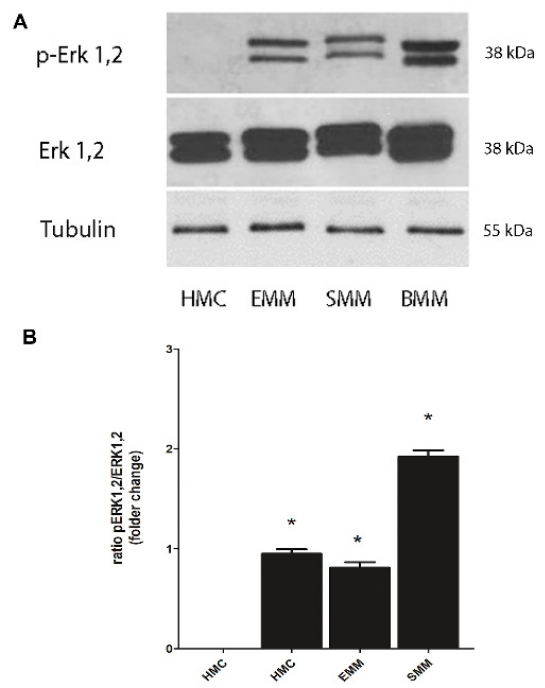
Figure 5. Erk phosphorylation mediates Nrf2 and FOXM1 activation. ( A ) Western Blot of phosho-Erk (p-Erk), Erk (1,2) and Tubulin proteins in HMC, EMM, SMM, and BMM cells. ( B ) Densitometric analysis of the relative expression of p-Erk versus Erk ( n = 3, * p < 0.001). Several mechanisms have been proposed to explain the activity of FOXM1 in cancer progression, including the activation of this factor by several oncogenic protein and signal- ing pathways, such as Ras and MAPK/Erk [29]. As for Nrf2, our results demonstrated an overexpression of the p-Erk in MPM cells (Figure 5A,B) and not in mesothelial